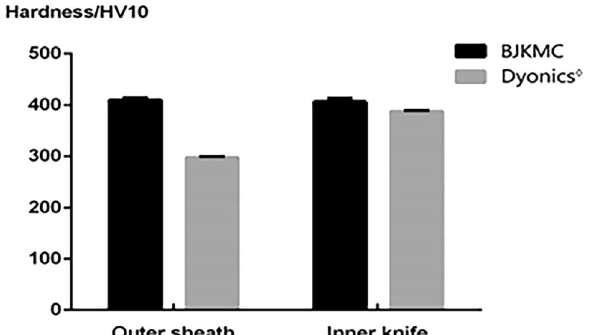
Figure 11. The data of hardness of shaver blade.